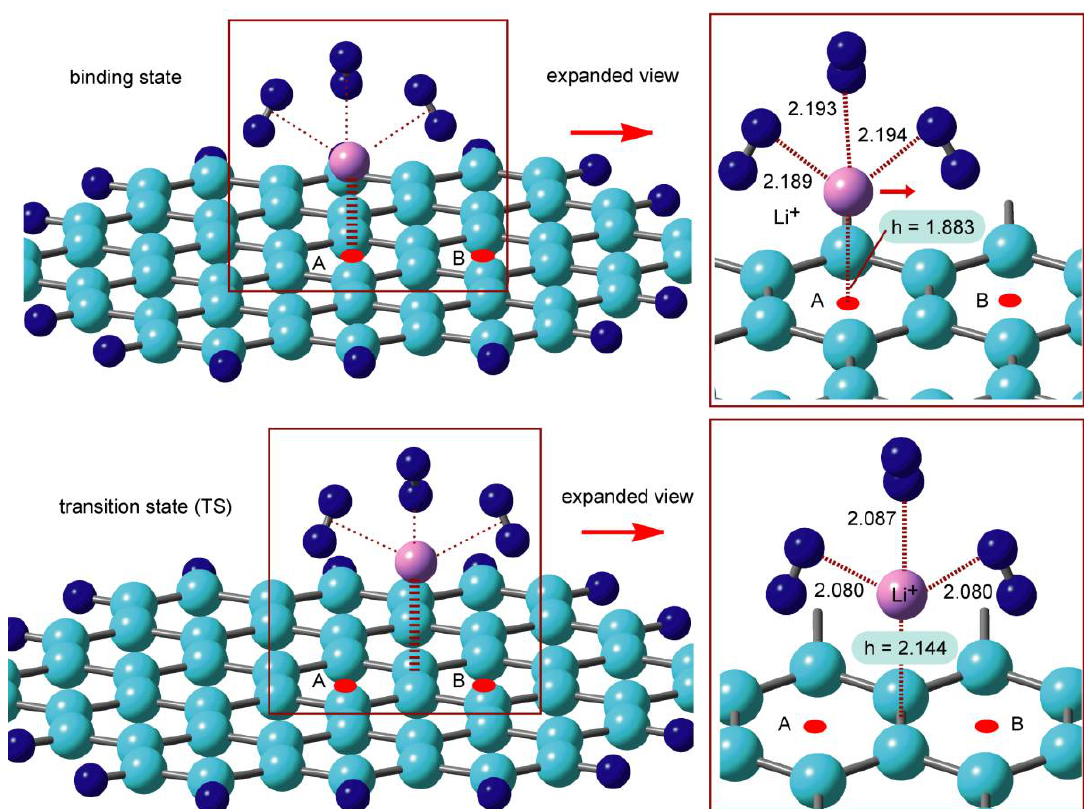
Figure 10. The optimized structures of GNF(19)–Li + –(H 2 ) n ( n = 3) in the ( upper ) binding state and ( lower ) transition state (TS) calculated at the CAM-B3LYP/6-311G(d,p) level. Bond distances are given in Å. Reprinted with permission from [38]. Copyright 2019 American Chemical Society.